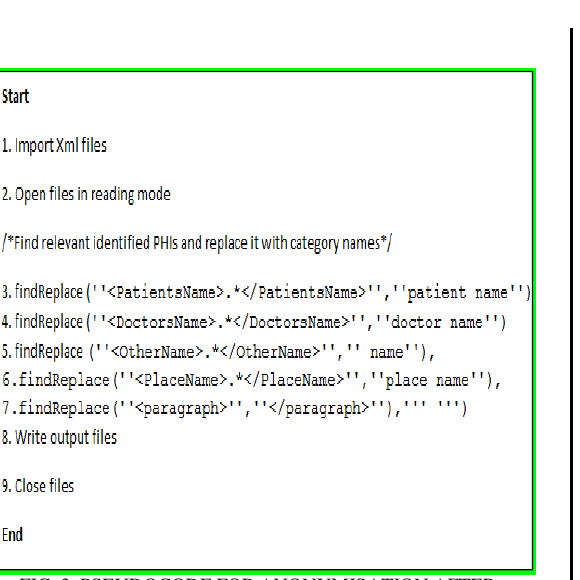
FIG. 3. PSEUDOCODE FOR ANONYMISATION AFTER IDENTIFICATION OF PHI